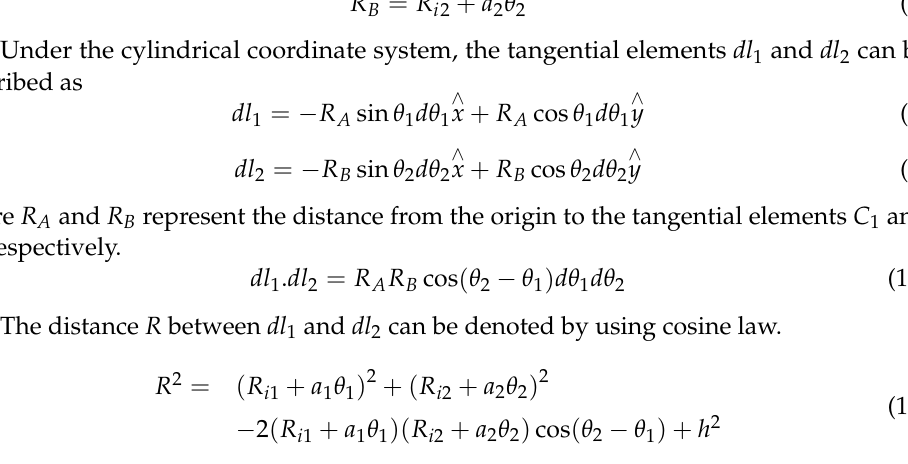
Figure 2. Planar spiral coil with lateral misalignment.